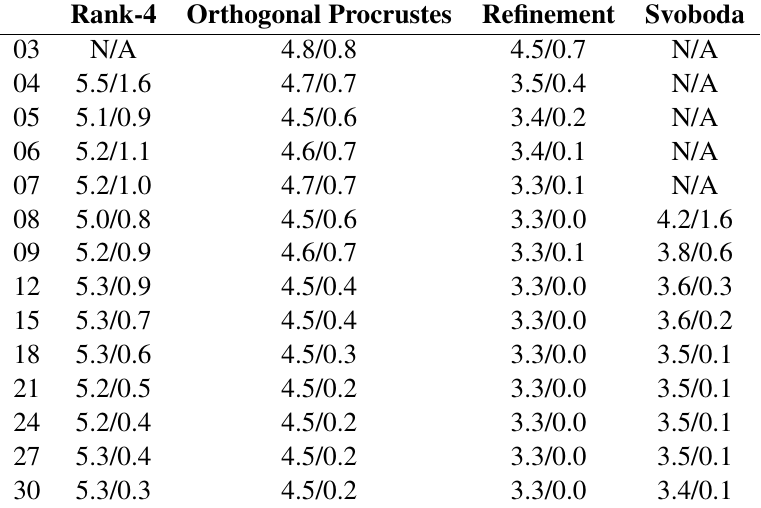
Table 3. Triangulation error (cm). The first column represents the number of training samples, and the first row gives the methods used for comparison. The refinement method uses the result of Orthogonal procrustes as initial guess, and then applies the proposed refinement method to improve the accuracy. The numbers are listed as “a/s” where a is the average over 100 experiments and s is the standard deviation.